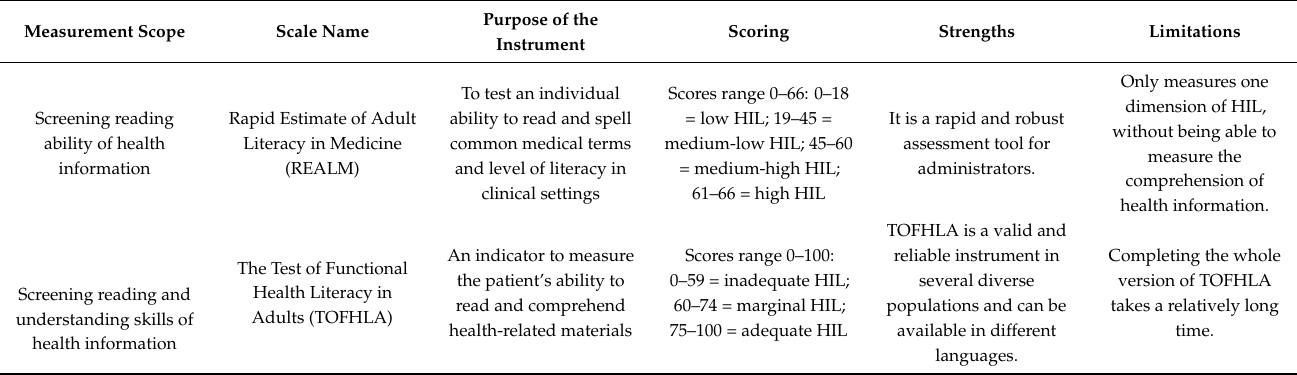
Table 1. Summary of tools assessing health information